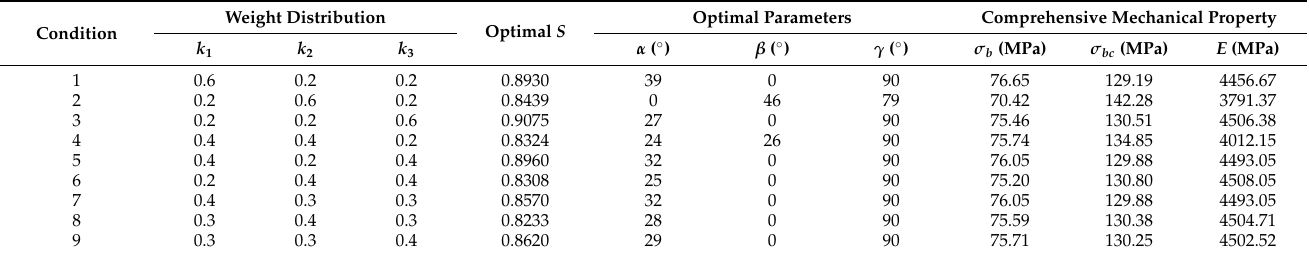
Table 7. The optimal parameters for comprehensive mechanical